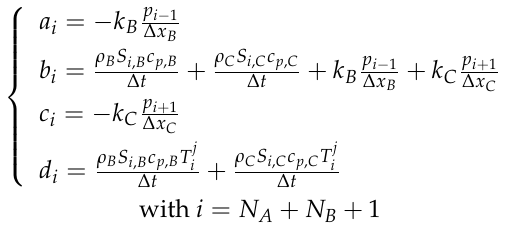
The elements in the outer jacket (gray color) are expressed with subscript C . As shown